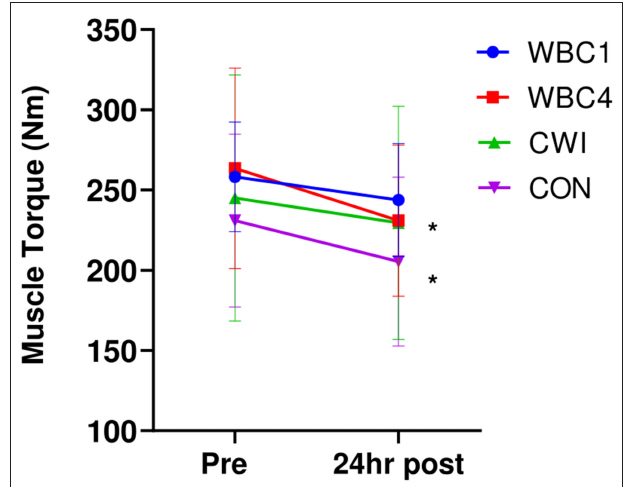
FIGURE 2 | Maximal muscle torques for WBC1, WBC4, CWI and CON groups. * p < 0.05 for decrease in WBC4 and CON only. Data presented as means ± standard deviations. N = 33.